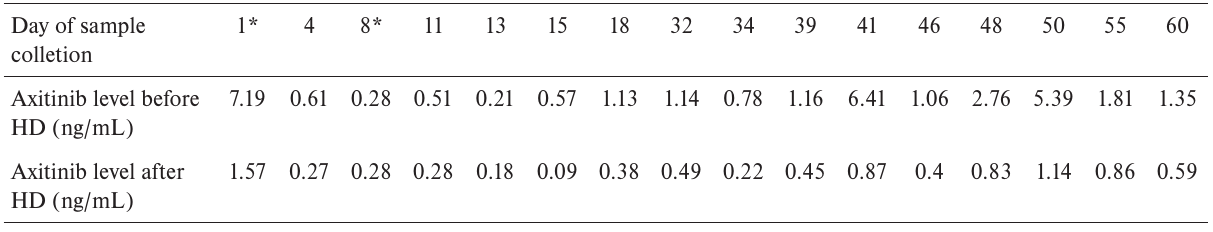
Table 2. Plasma concentrations of axitinib measured during hemodiafiltration